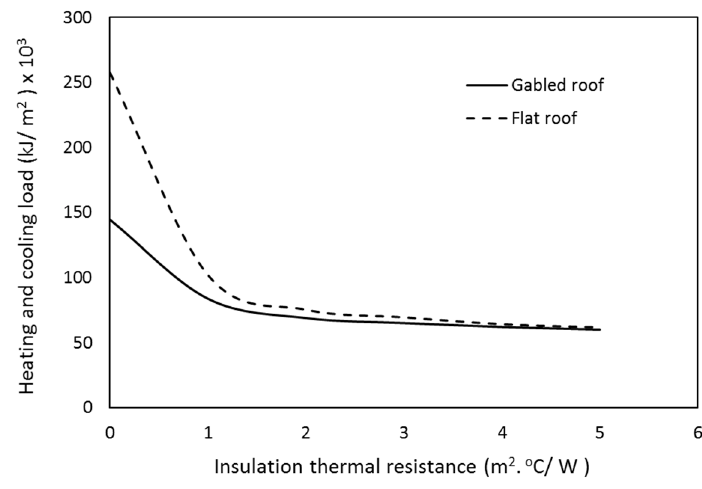
Figure 7. The effect of the ceiling insulation’s thermal resistance on the annual heating and cooling load of a dwelling with a gabled roof design and a dwelling with a flat roof design.